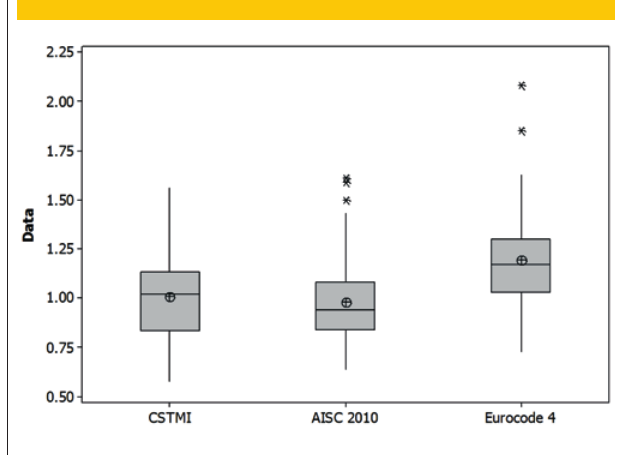
Figure 5 – Histogram of R ratios Figure 6 – Box-plot of R ratios for each